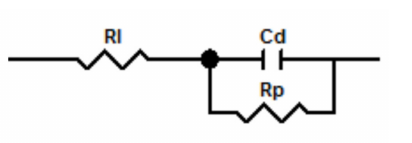
Figure 10. Nyquist plot of the alloy.